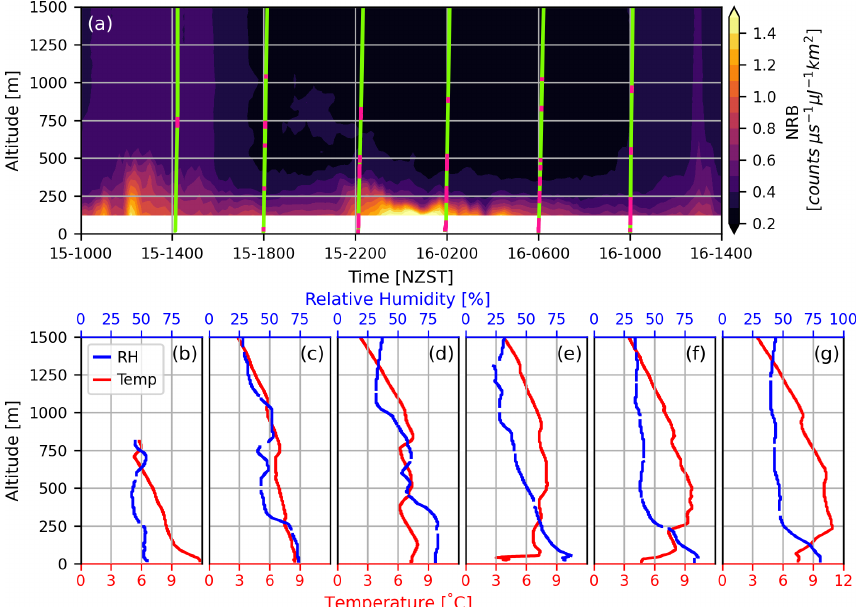
Figure 7. (a) Normalised relative backscatter (NRB) curtain taken by the miniMPL between 10:00NZST, 15 August and 14:00NZST, 16 August 2019. The dashed green lines indicate the timing of the six radiosondes launched in this period with temperature inversions highlighted in pink. (b–g) Relative humidity and temperature profiles measured with GRAW DFM-9 radiosondes during the same period, shown in chronological order.